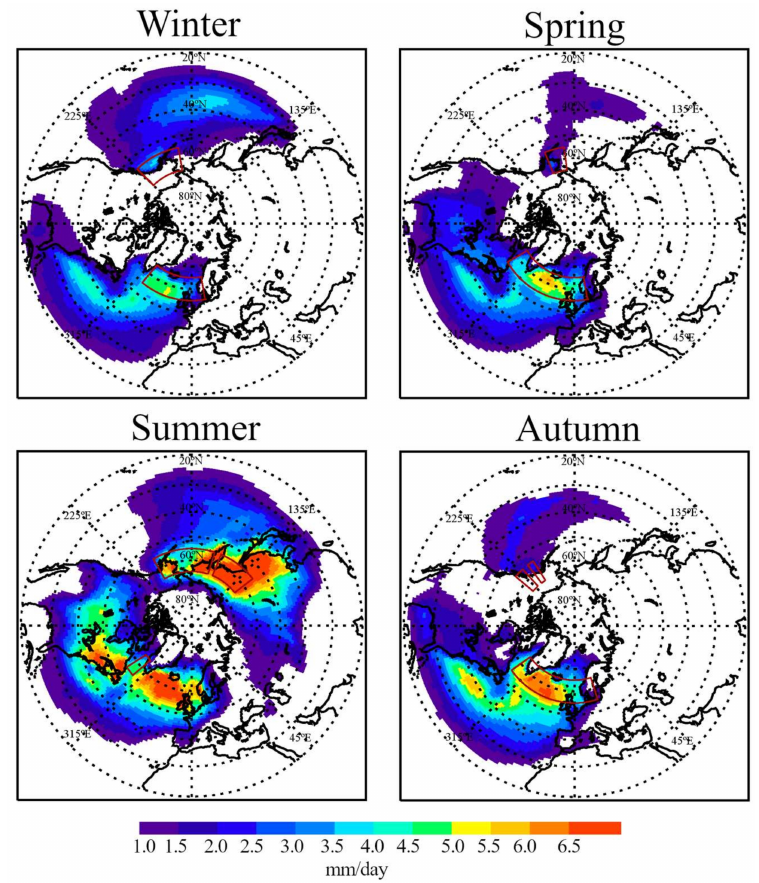
Figure 3. Anomalies for AR moisture uptake ( ( E − P ) ANOM > 0) calculated for those days when an AR event was identified over the AR pathway regions (red boxes) and referring to the climatological value over the period 1997–2014. Scale in